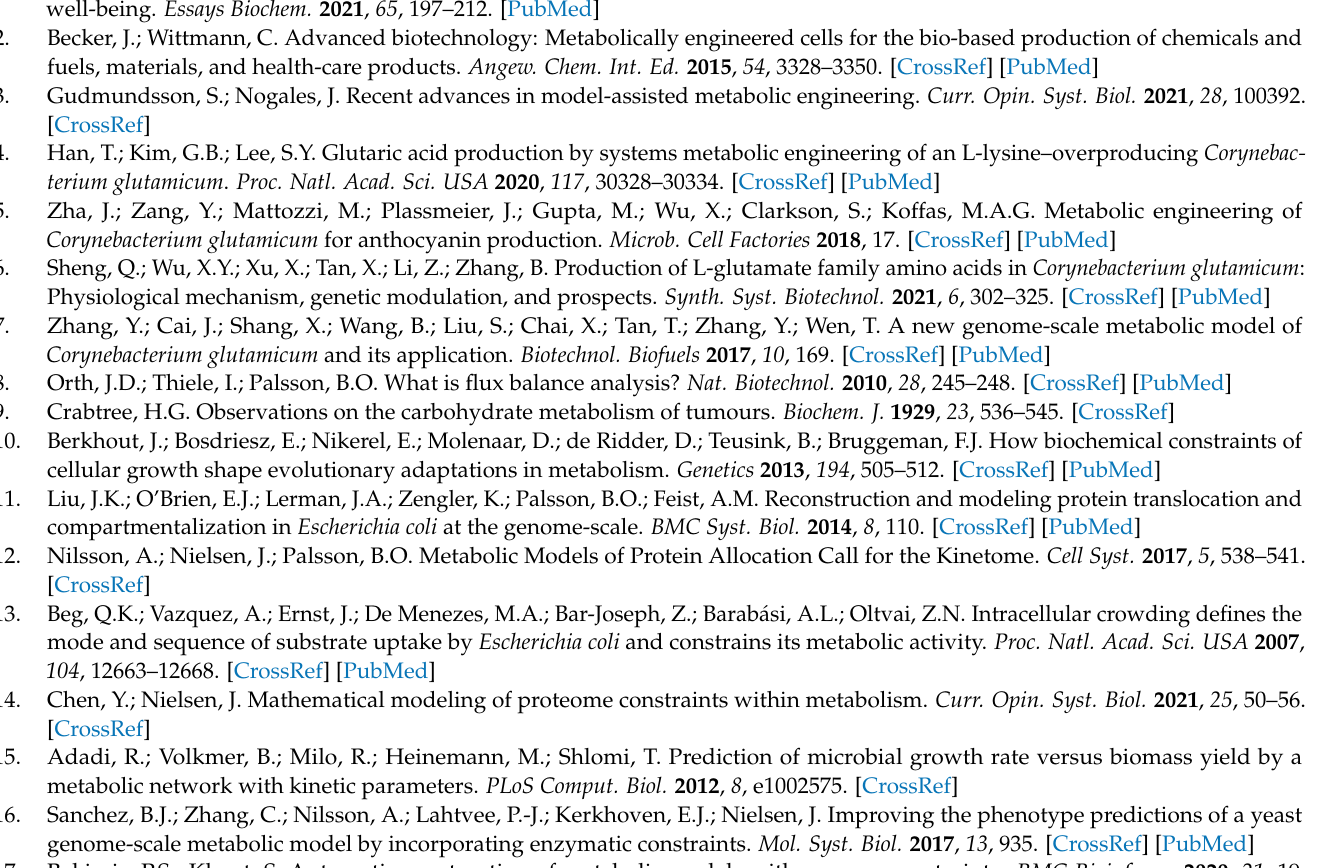
Table S4: GPR Modifications by homology similarity; Table S5: Reactions for k cat